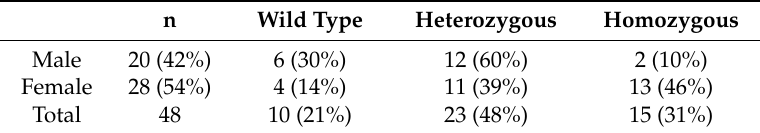
Table 1. Genotype of 48 Golden Retriever for the PNPLA1 gene